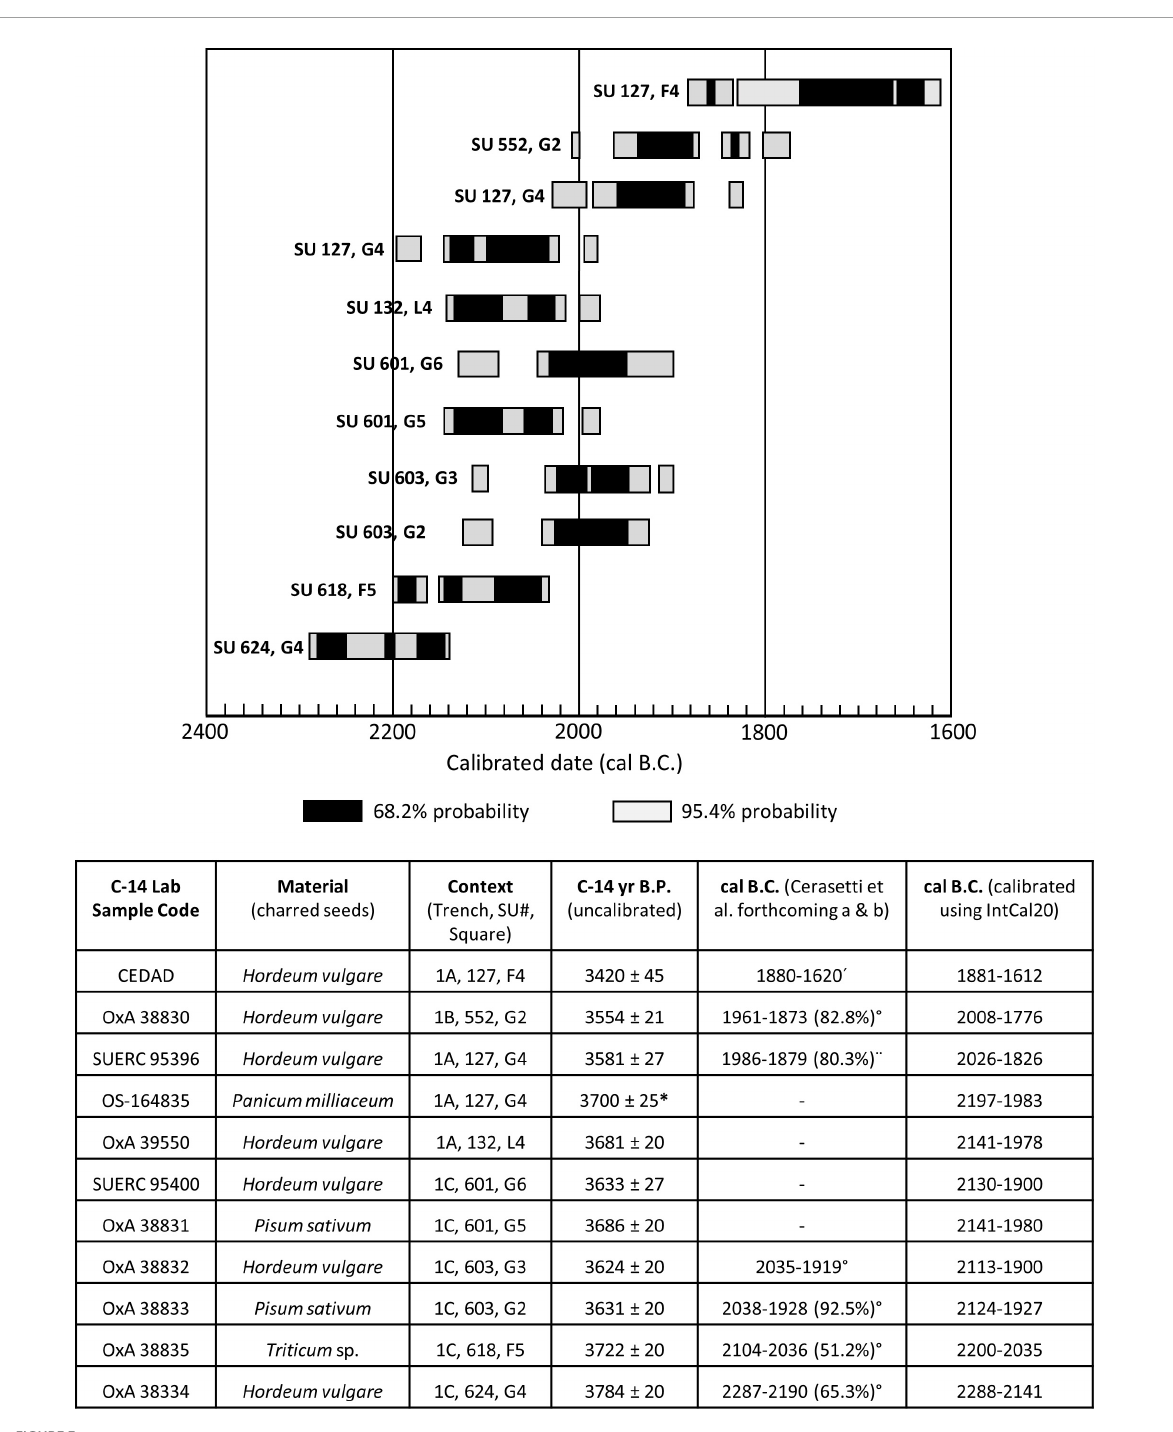
FIGURE3 Accelerator mass spectrometry (AMS) radiocarbon dates from Togolok 1 (Cerasetti et al., in press a, in press b). Specific context from given as (trench, stratigraphic unit [SU], square). Graph adapted from OxCal v4.4.4 (Bronk Ramsey, 2009) with corresponding dates in last column of table. All dates were calibrated with 95.4% probability unless otherwise noted using IntCal20 (Reimer et al., 2020). Symbol key: (cid:48) Dates calibrated with OxCal 3.10 (Bronk Ramsey, 1995, 2001), IntCal13 (Reimer et al., 2013). ◦ Dates calibrated with OxCal 4.3.2, Bronk Ramsey (2009), IntCal13 (Reimer et al., 2020). .. Dates calibrated with OxCal 4.4.2 (Bronk Ramsey, 2009), IntCal20 (Reimer et al., 2013). *Newly reported date from this publication. Codes for labs: CEDAD- CEntro di Fisica applicata, DAtazione e Diagnostica, University of Salento, Italy; SUERC-